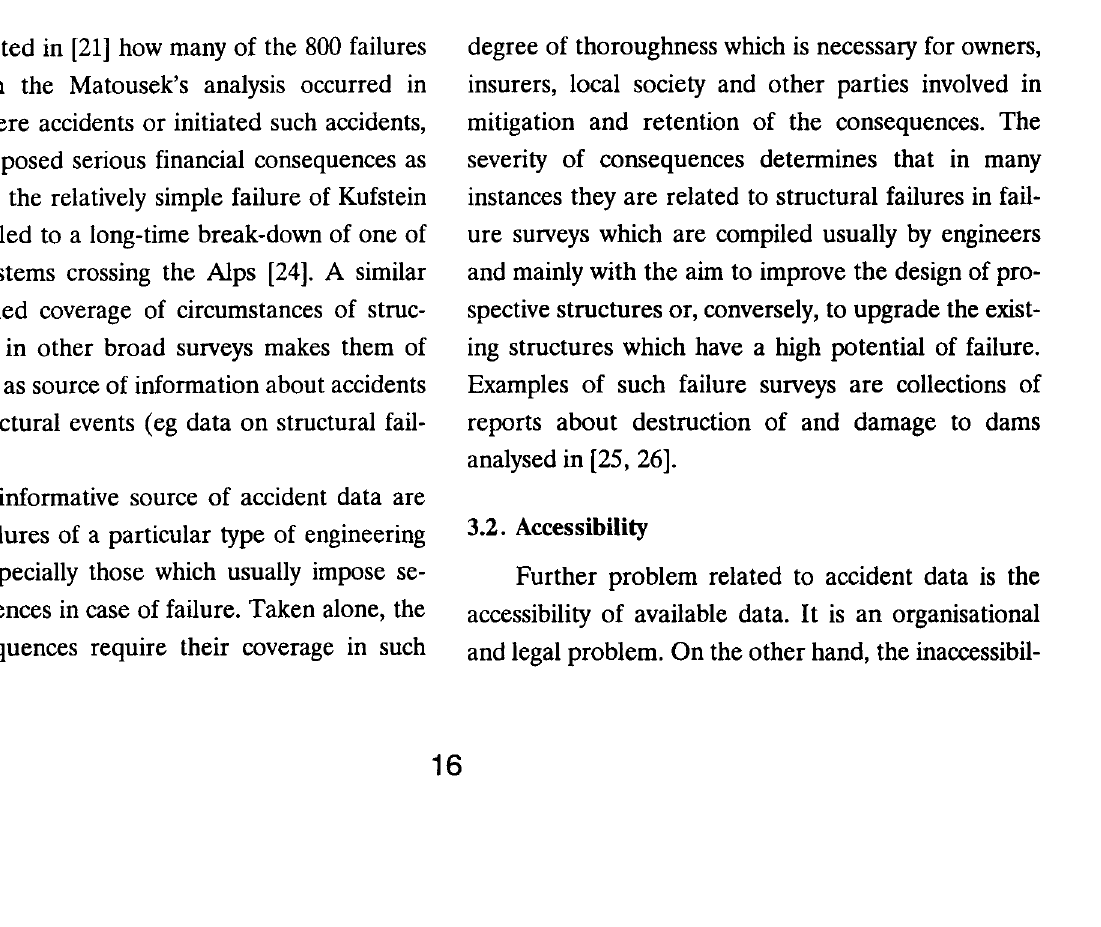
Table 4. Consideration of hazardous influences" Way of consideration